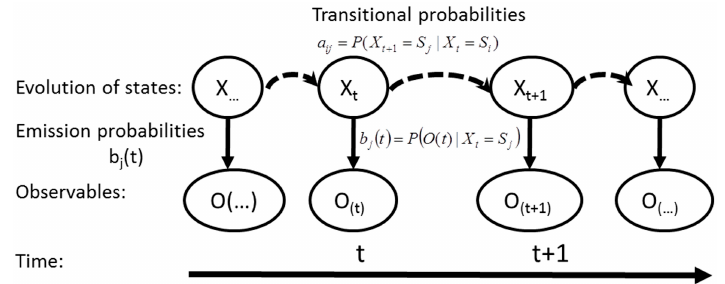
Figure 3. Structure and temporal evolution process of a hidden Markov model